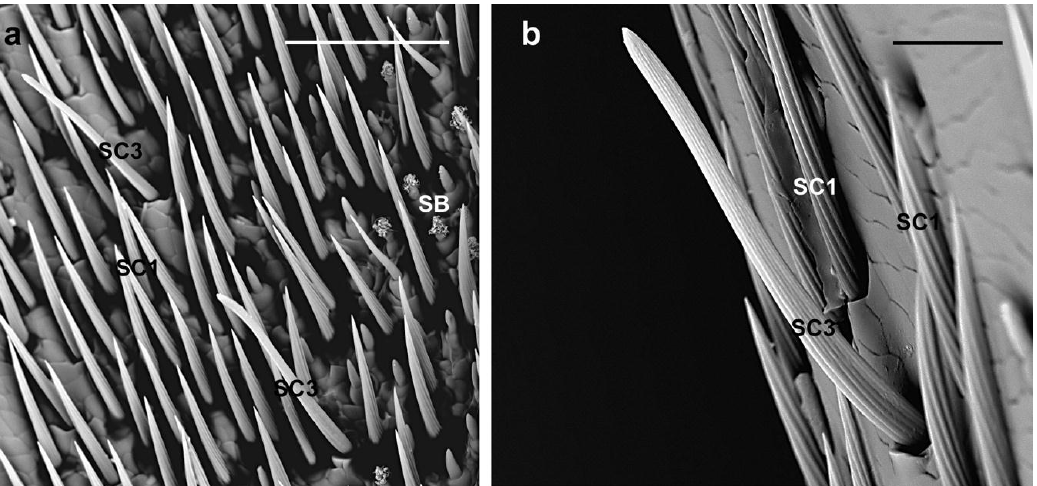
Figure 5. A. bungii , SEM. Sensilla chaetica SC3. ( a ) Female: Two SC3 with several SC1 and some SB (different types). ( b ) Male: Detail of one SC3 with thin parallel grooves and blunt tip (compared to SC1). SC1, sensillum chaeticum type 1; SC3, sensillum chaeticum type 3; SB, sensilla basiconica. Scale bars: 50 µm ( a ); and 30 µm (b).